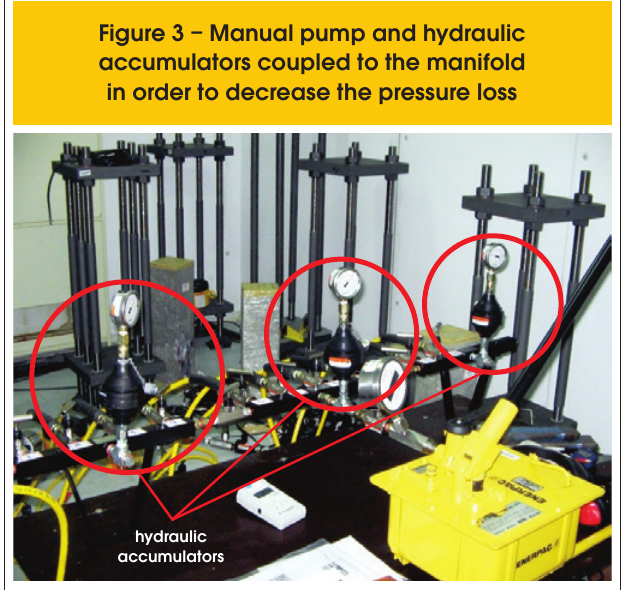
Figure 3 – Manual pump and hydraulic accumulators coupled to the manifold in order to decrease the pressure